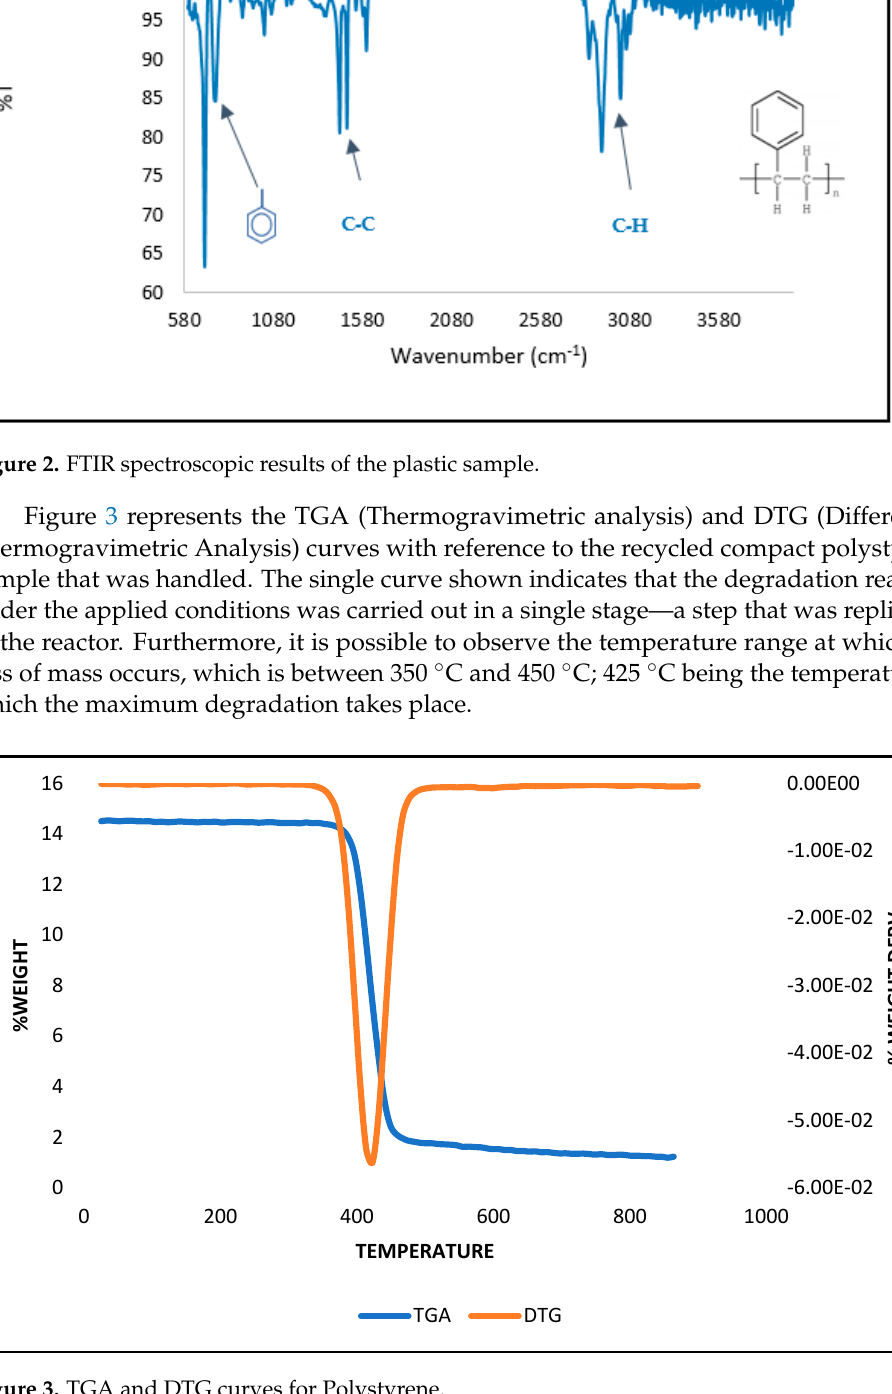
Figure 3. TGA and DTG curves for Polystyrene.